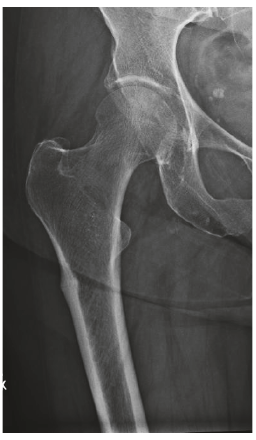
Figure 3: Atypical subtrochantericfemur fracture:Initial identifica- tion of atypical subtrochanteric femur fractures can be identified by characteristic lateral cortical